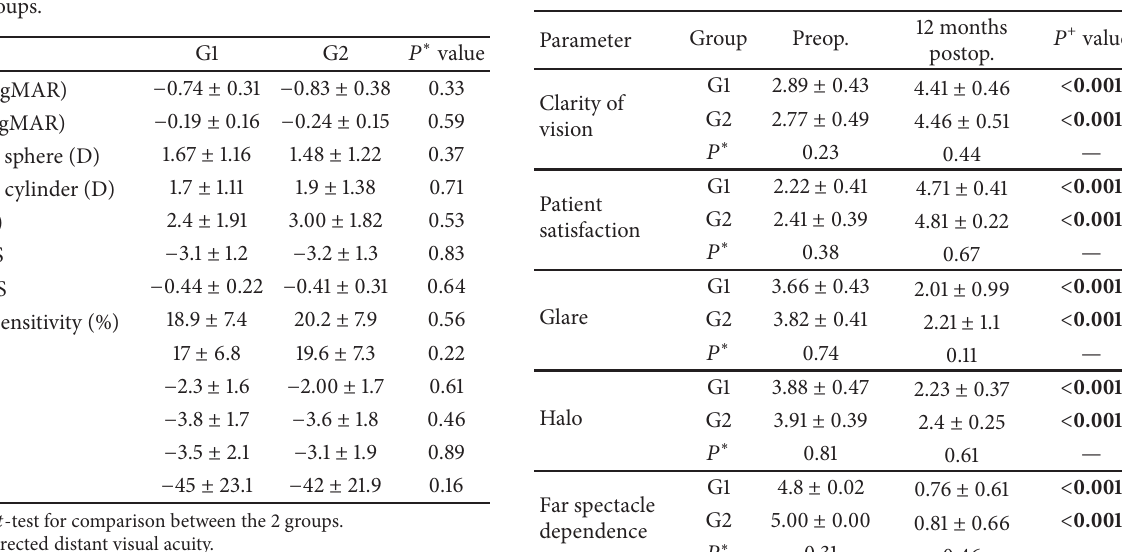
Table7:Patientself-assessedmeansubjectiveratingspreoperatively and 12 months postoperatively in both groups (mean ± SD).